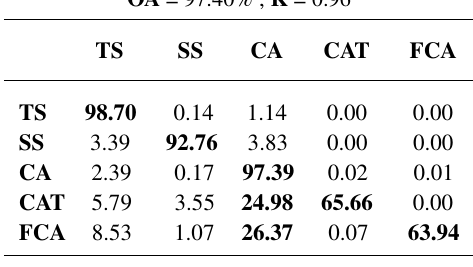
Table 2. Confusion matrix January 2018